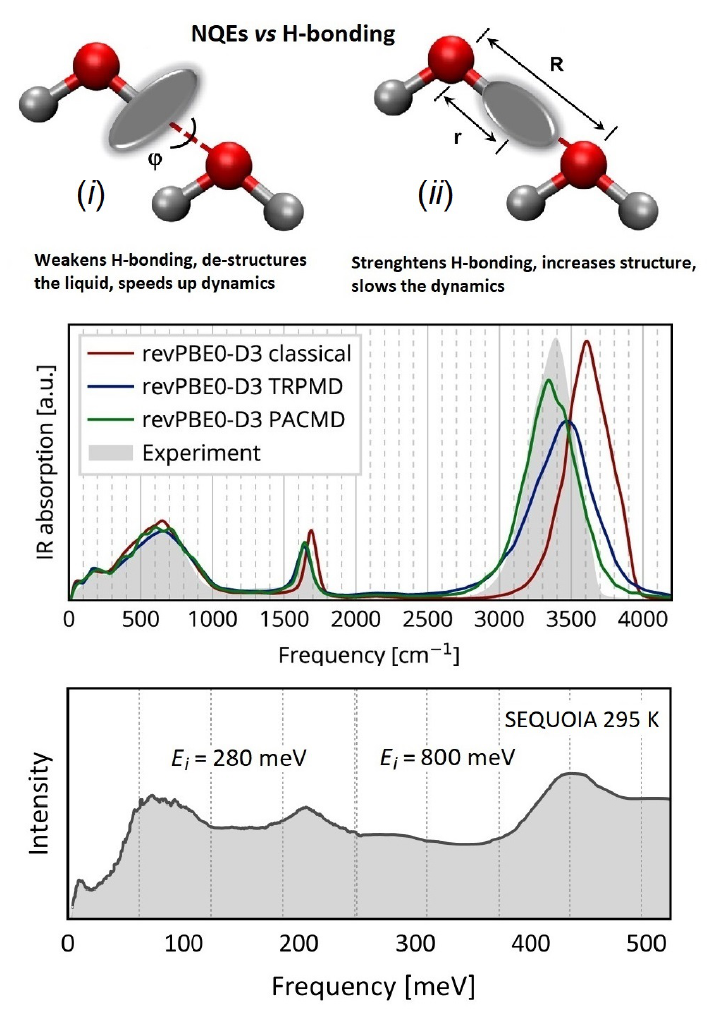
Figure 14. Bottom: experimental INS spectrum of liquid H 2 O measured on SEQUOIA at ambi- ent conditions. Two different incident energies have been used, as indicated in the figure [388]. Middle: experimental IR spectrum of H 2 O at ambient conditions, along with the results of AIMD predictions using vdW-corrected hybrid-DFT (revPBE0-D3 ML-FF) and different computational schemes—classical MD and approximate path-integral simulations (TRPMD and PACMD) [376]. Top: cartoon illustrating competing quantum effects in the H-bonding between two water molecules. There are two qualitatively different contributions to the vibrational ZPE: ( i ) the one arising from the two bending vibrational modes, in the plane of the water molecule and perpendicular to it (not shown); ( ii ) a second one associated with the O–H stretch. As the O–O distance R decreases, the contribution of the stretch decreases, and that of the bend increases. Consequently, the two contributions weaken and strengthen the intermolecular H-bond, respectively. [367]. Adapted with permission from Refs. [367,376,388]. Copyright (2021) American Chemical